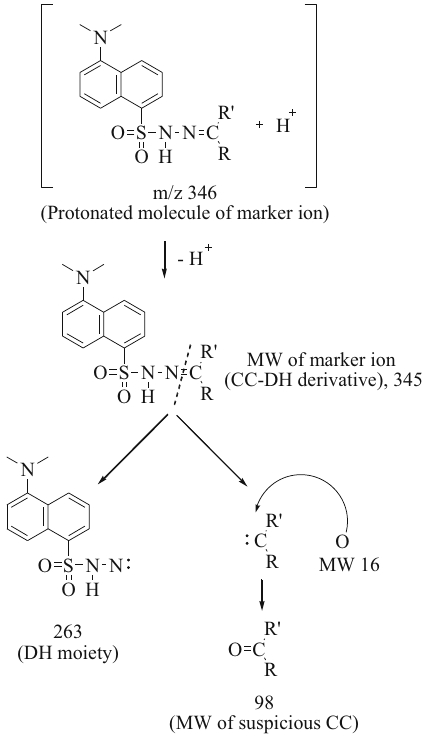
Figure 4: The fragment elucidation of marker ion for obtaining the molecular weight of predominant CC in the fi rst layer of fresh